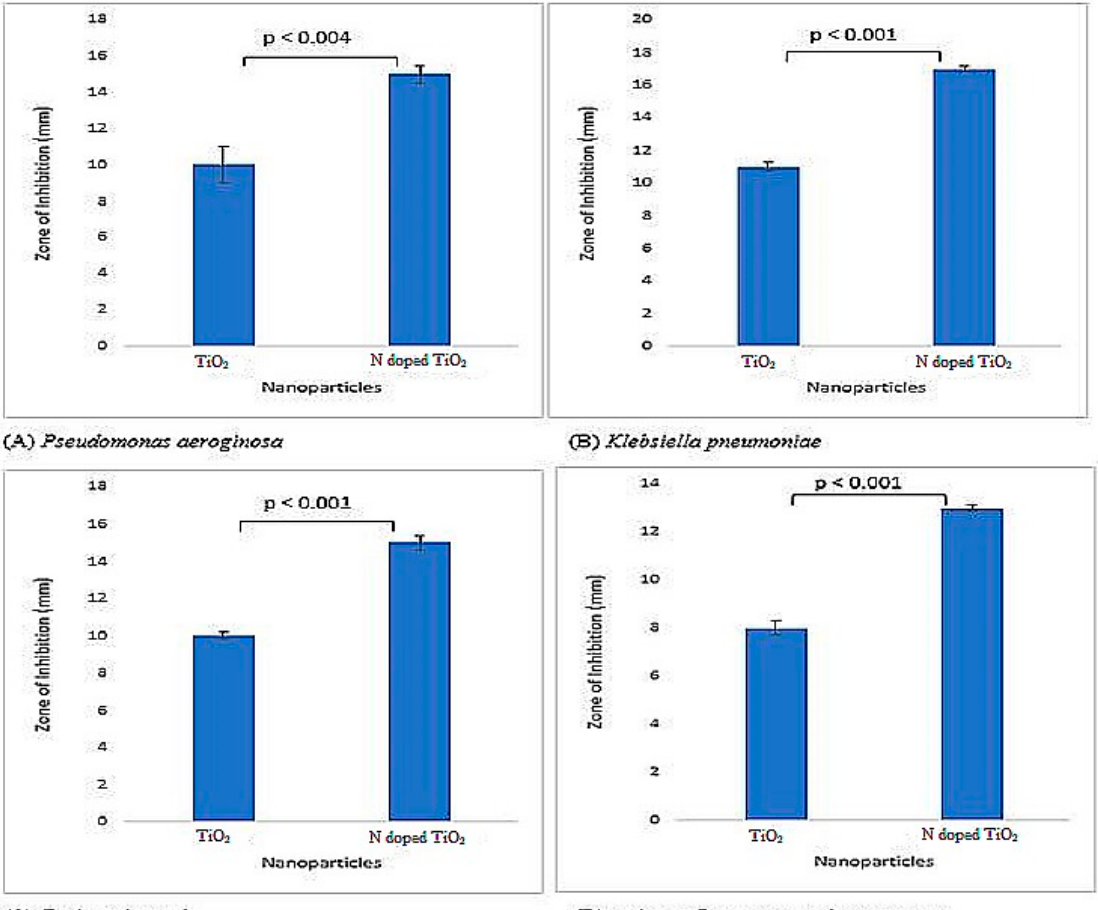
Figure 6. Antibacterial activity exhibited by TiO 2 nanoparticles and N-doped TiO 2 nanoparticles against Gram-negative bacterial strains; ( A ) Pseudomonas aeroginosa , ( B ) Klebsiella pneumoniae , ( C ) Escherichia coli , ( D ) resistant Pneumococcal aeruginosa. Error bars are shown as standard deviation on each bar. Bars are significantly different at confidence interval level of 95%.